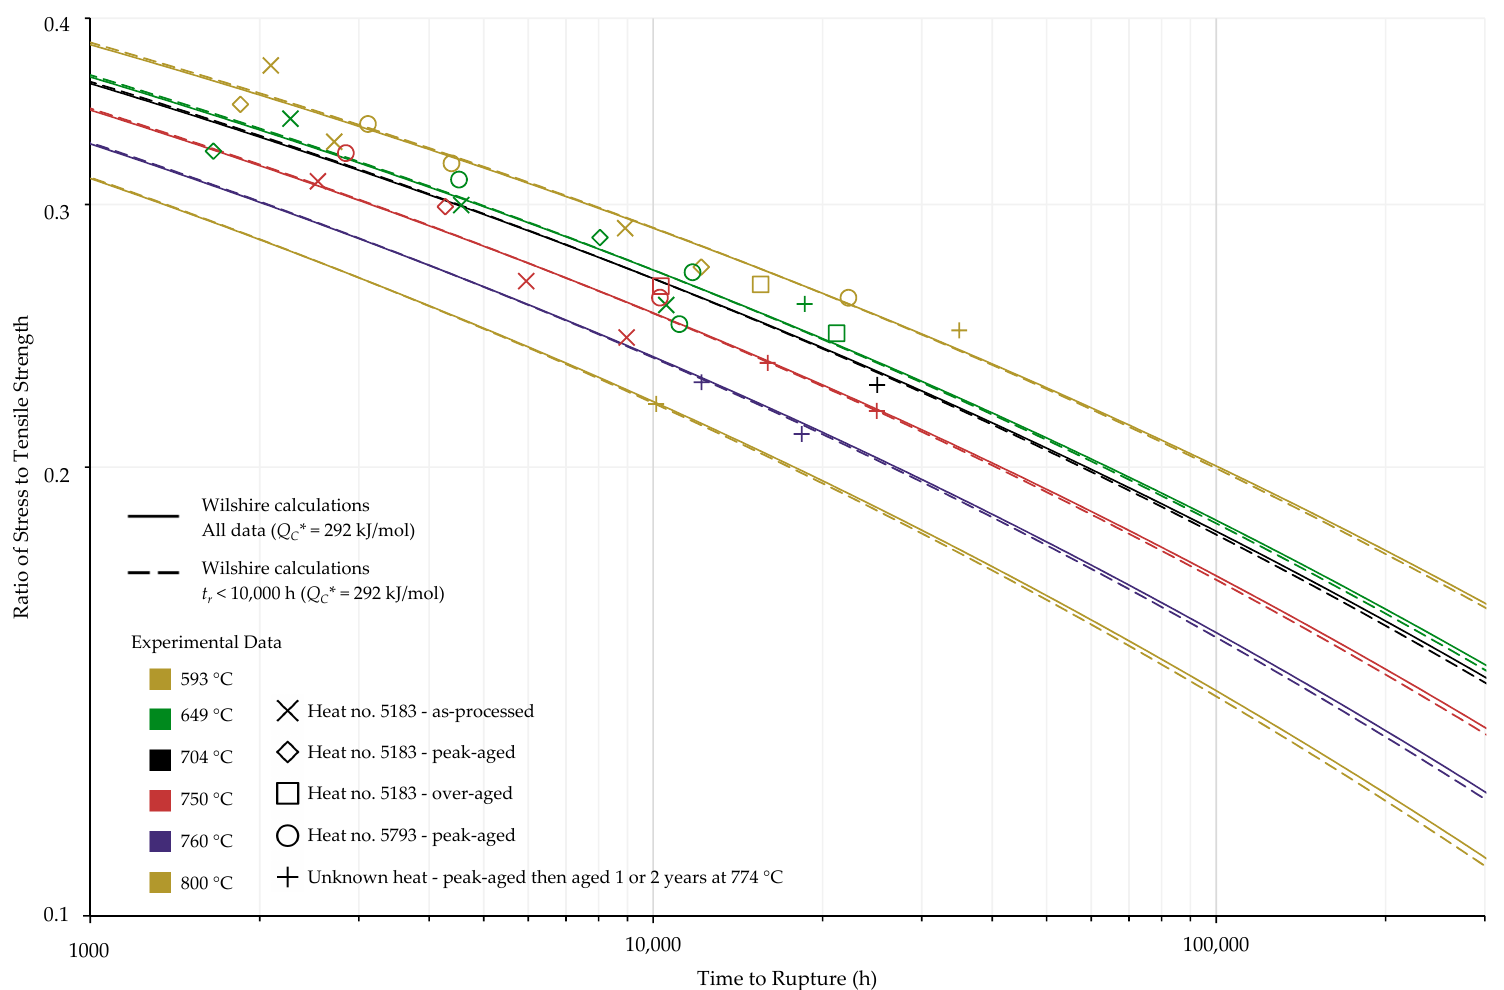
values.0.1 Figure 6. Calculations of the Wilshire equation with the lowest error for Nimonic 105 using heat- and processing-specific tensile strength